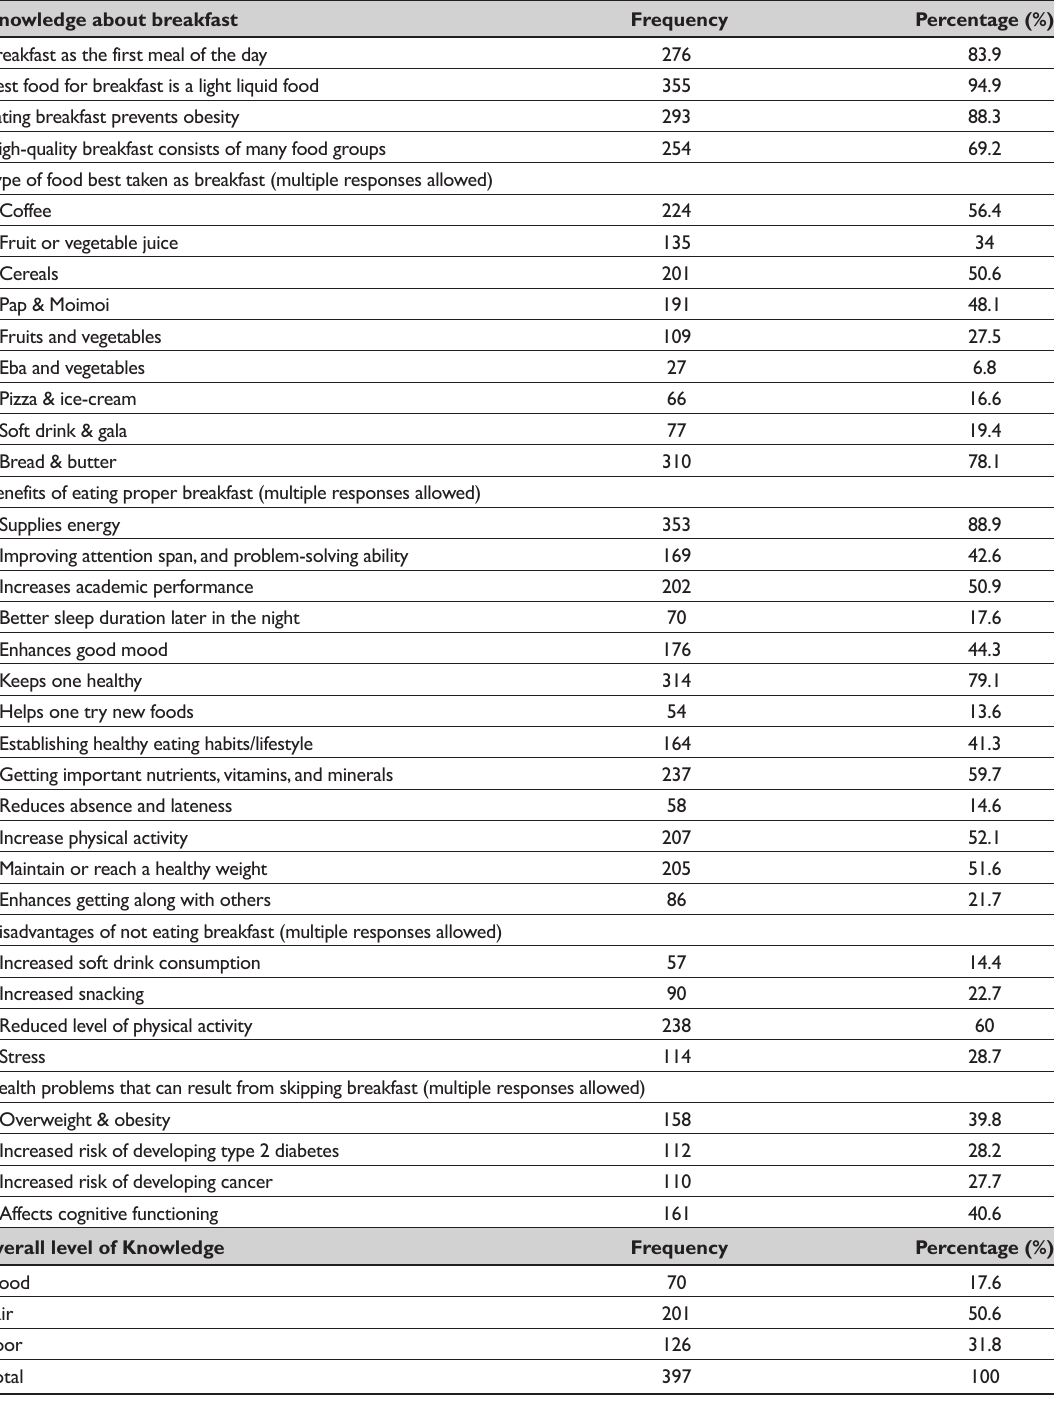
Table 1: Knowledge about breakfast consumption and its effects Knowledge about